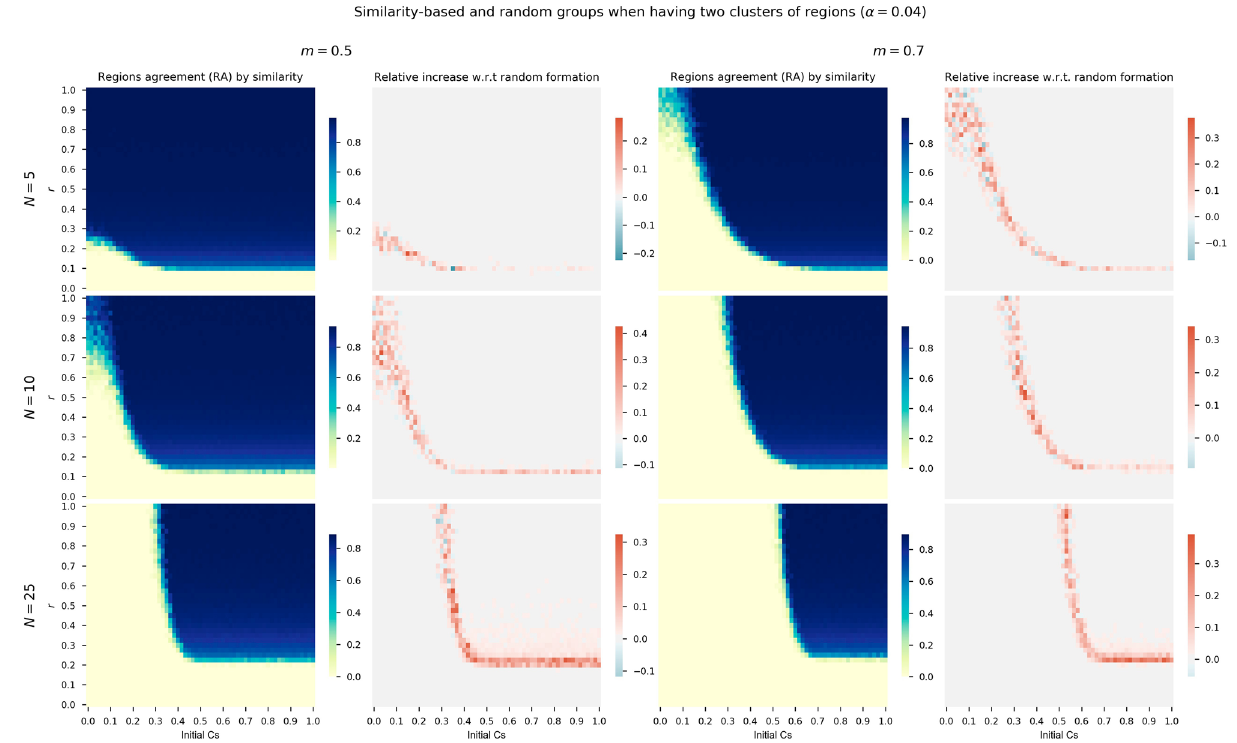
Figure 7. First and third columns show heatmaps of absolute RA when considering two clusters of regions ( α = 0.04 ) and grouping regions at random for thresholds m = 0.5 and m = 0.7 . The second and fourth columns show relative RA differences when using two clusters of regions grouped by similarity with respect to random